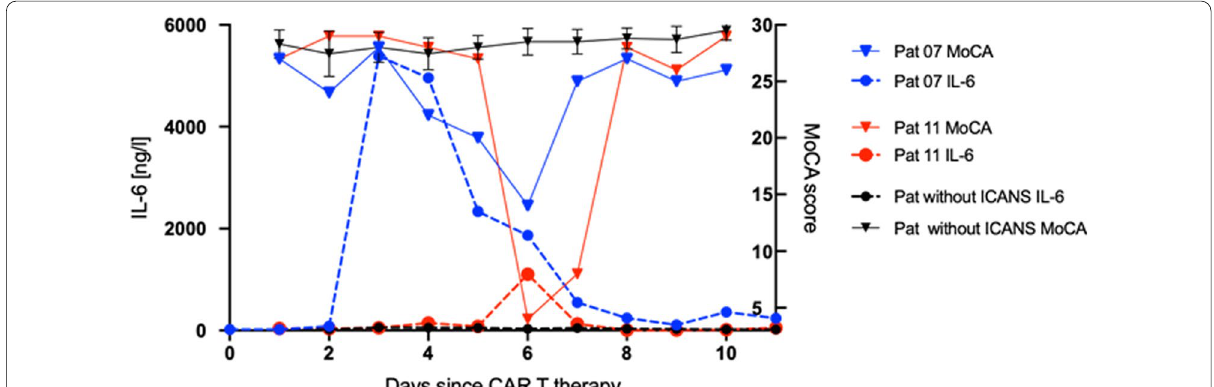
Fig. 4 IL‑6 levels and MoCA scores of two exemplary ICANS patients compared with all patients that neither had ICANS nor CRS Day 0: day of CAR T cell therapy. Patients 7 and 11 developed immune effector cell‑associated neurotoxicity syndrome (ICANS) grade 2. MoCA: Montreal Cognitive